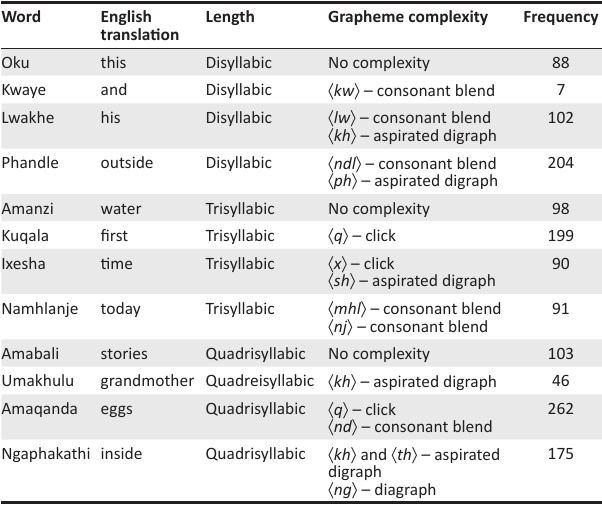
TABLE 1-A1: Real words – Spelling task.